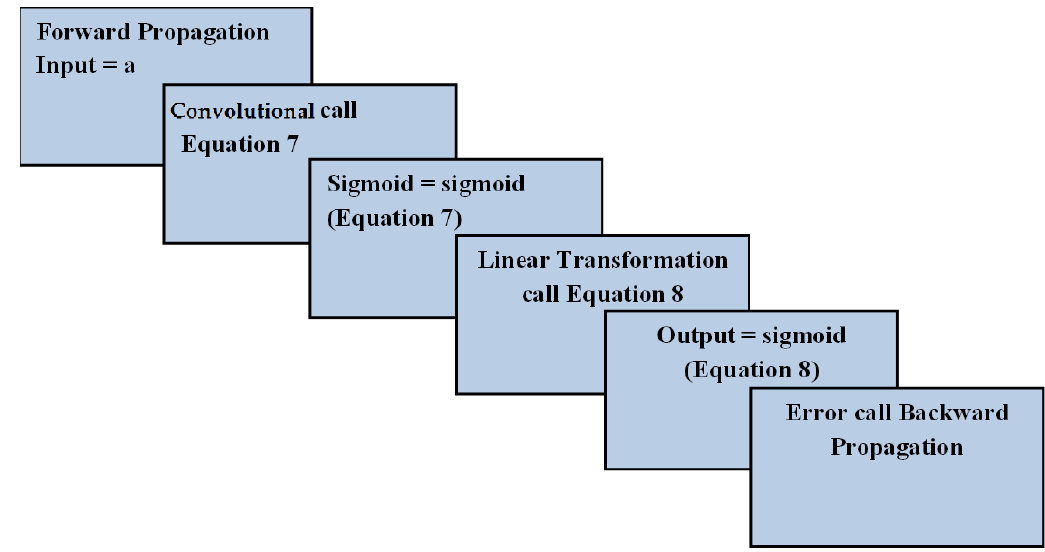
Figure 4. Workflow of forward propagation.